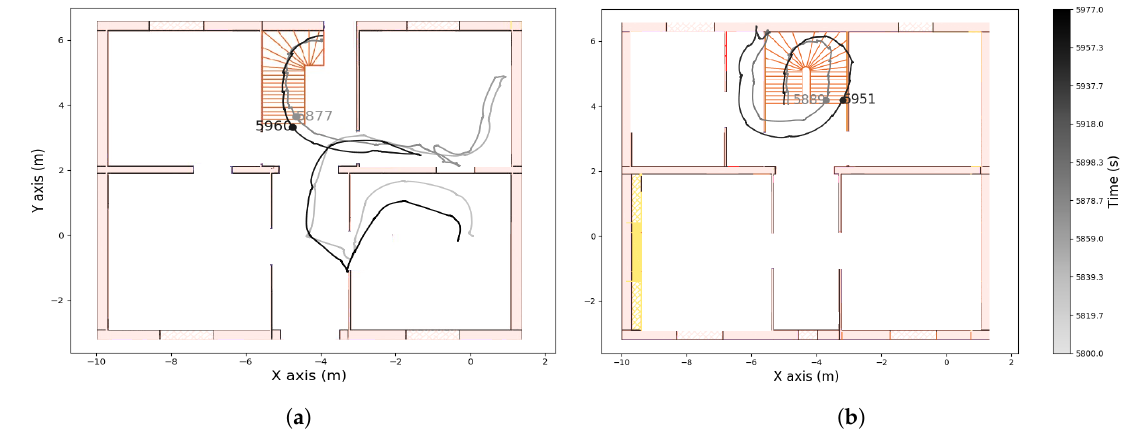
Figure 9. Computed trajectory during the first walking period on ( a ) the ground floor and ( b ) the first floor.